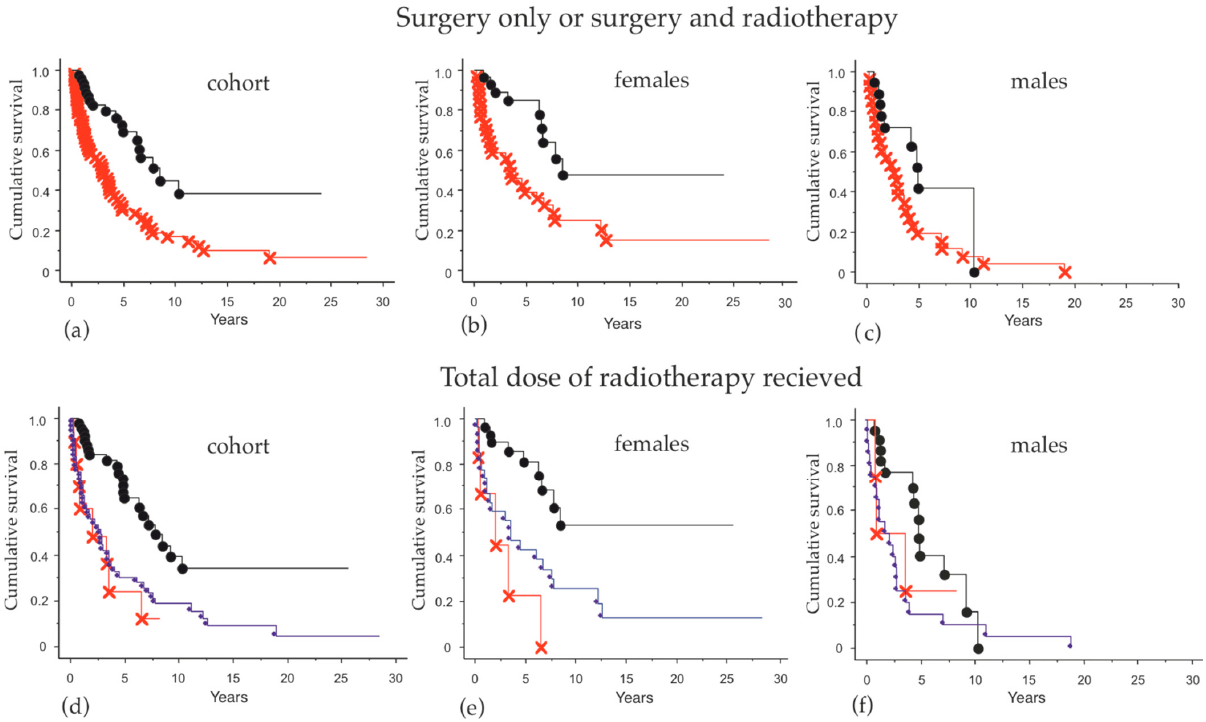
Figure 3. Overall survival in patients receiving surgery alone, a combination of surgery and adjuvant radiotherapy (RT), as well as radiation doses ( a – c ). Comparisons of overall survival between patients treated with surgery alone (red) and surgery plus adjuvant RT (black) in: ( a ) the entire cohort, p = 0.0001; ( b ) female patients only, p = 0.002; and ( c ) male patients only, p = 0.03. ( d – f ) Comparisons of overall survival among patients treated with radiation ≥ 50 Gy (black), <50 Gy (red) and patients never exposed to radiotherapy (blue) in: ( d ) the entire cohort, p = 0.0001; ( e ) only female, p = 0.0005; and ( f ) only male patients, p = 0.07.